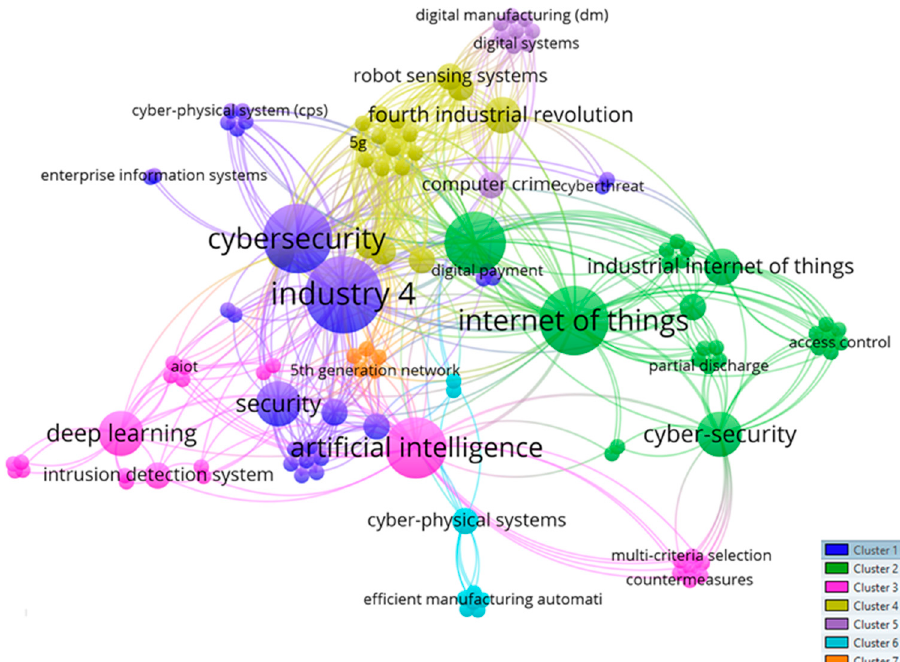
Figure 2. Keywords.